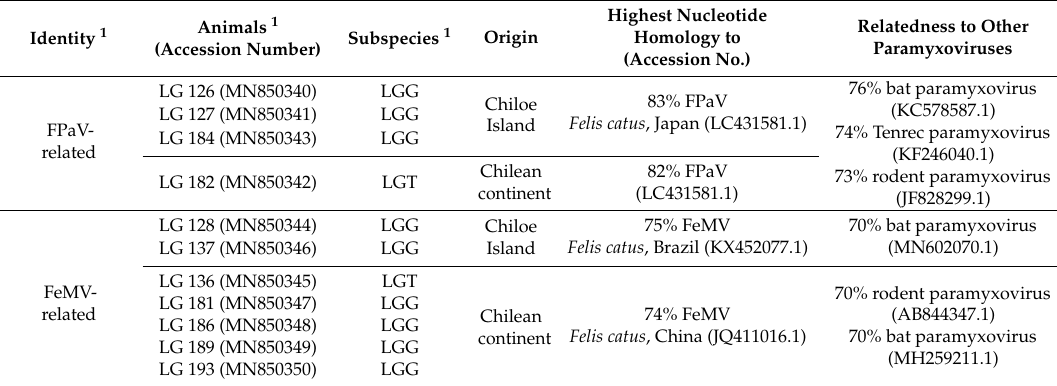
Figure 2. Maximum likelihood phylogenetic tree of paramyxoviruses including novel viruses detected in guignas from Chile (red dots). Accession numbers are shown in brackets. The tree is drawn to scale, with branch lengths measured in the number of substitutions per site. Table 1. Characteristics of paramyxovirus PCR-positive guigna